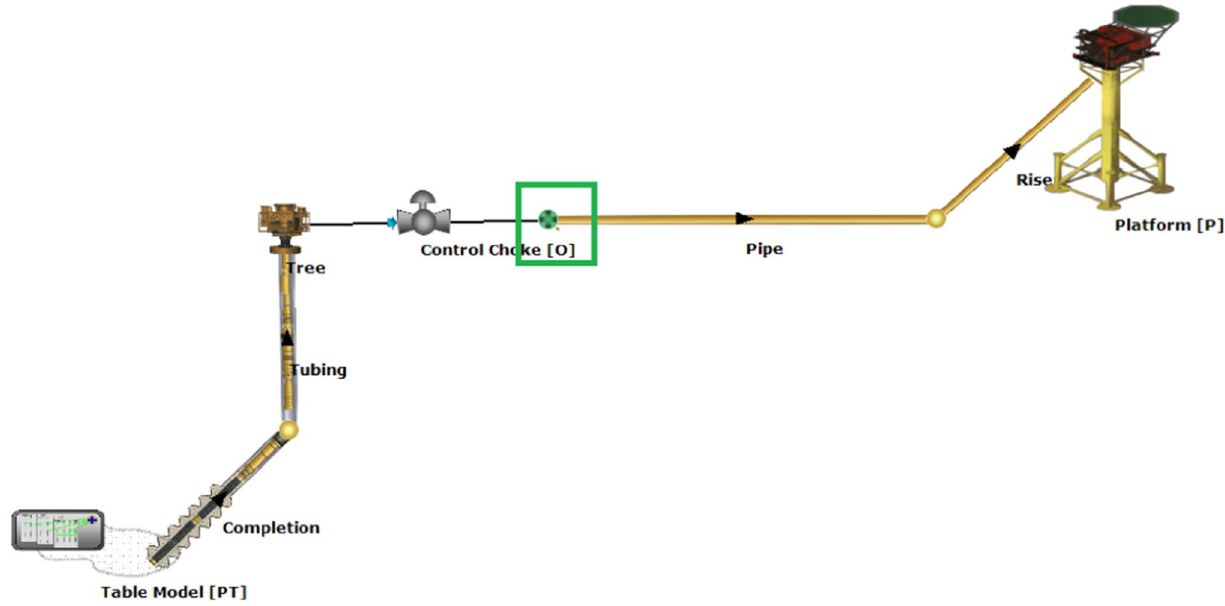
Fig. 9 Complete production model showing source used for